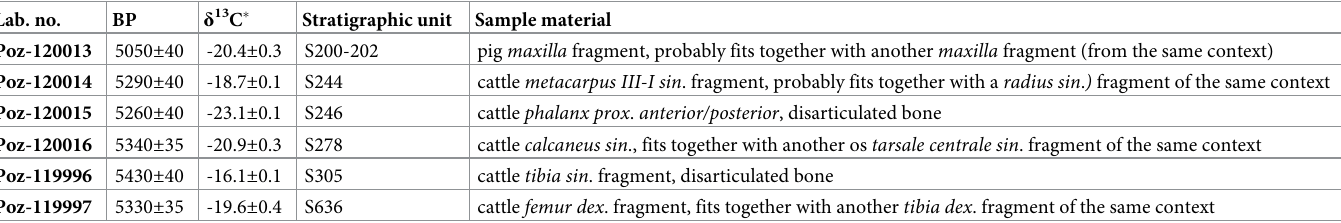
Table 1. The material and archaeological context of radiocarbon data. Lab.